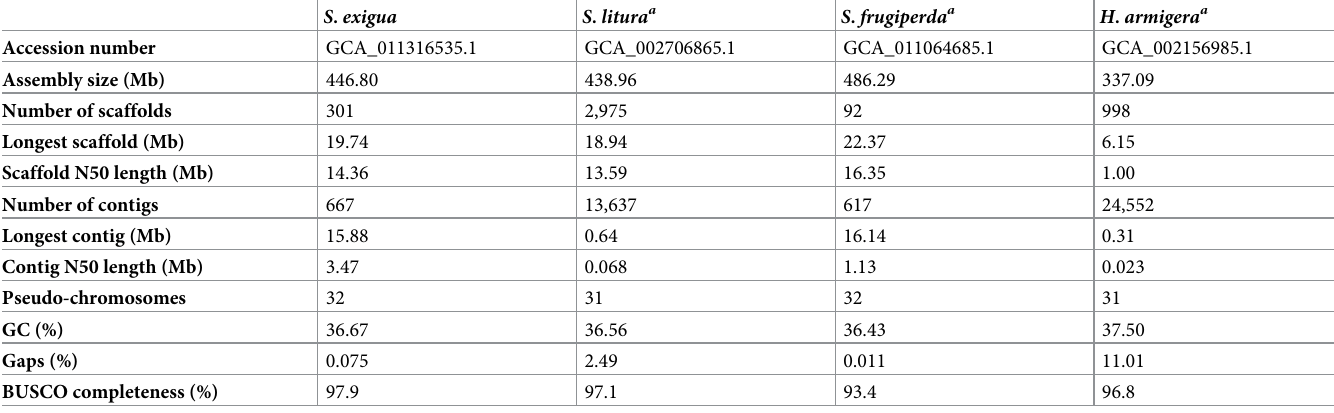
Table 1. Genome assembly metrics for four Noctuidae